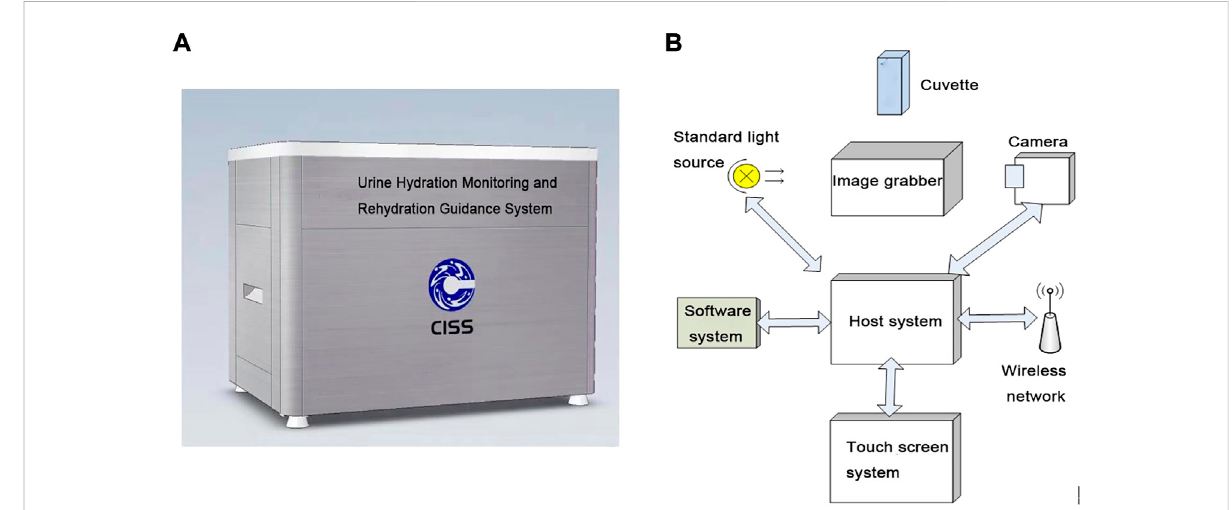
FIGURE 1 System design. (A) Schematic of the appearance of the system. (B) Schematic of system